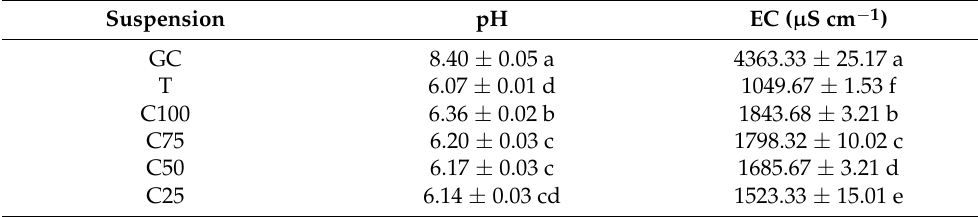
Table 2. pH and electrical conductivity (EC) measurements for sample/distilled water suspension (1:5, w / v ) of: green compost (GC); potting soil (T); mixtures containing the four different proportions of compost (C100, C75, C50,